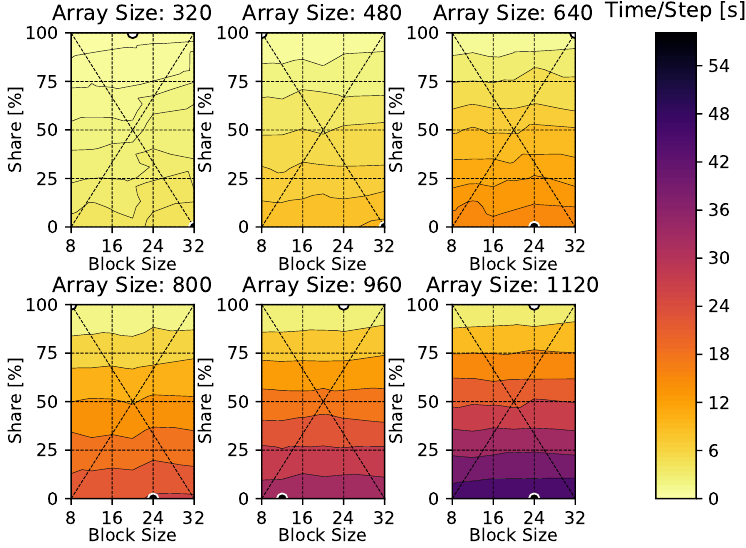
Figure A8. Euler equations time per timestep performance using Standard to solve the Euler equations with Intel Skylake Silver 4114 CPUs and GeForce GTX 1080 Ti